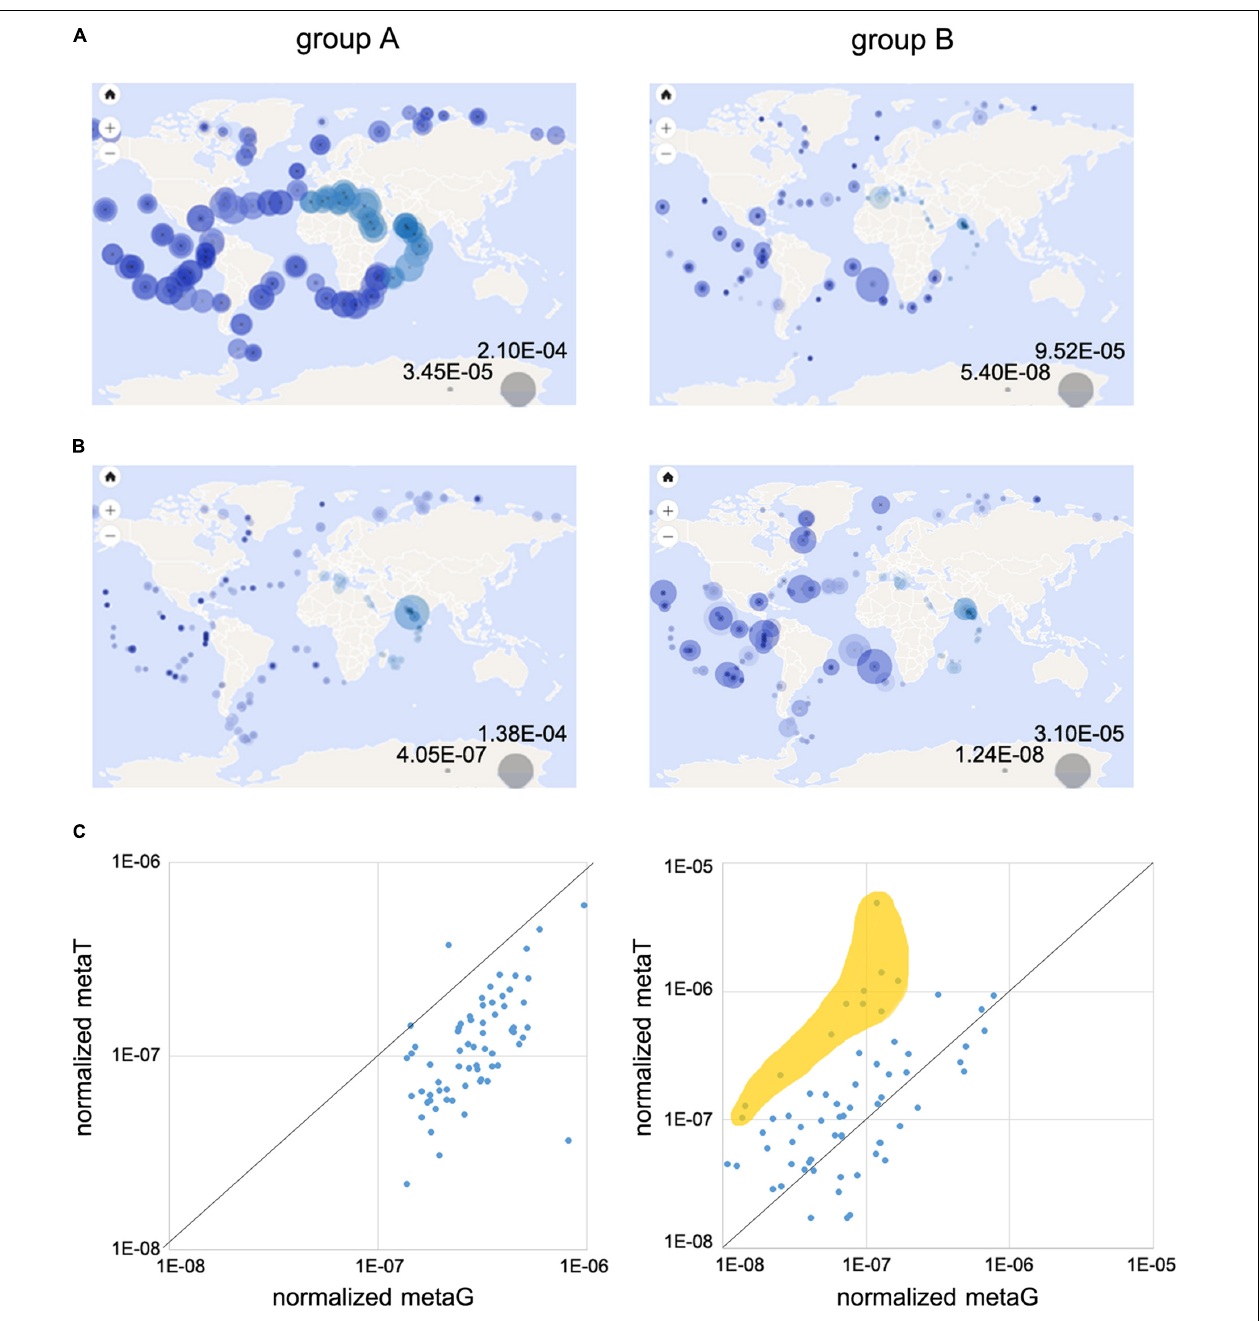
FIGURE 5 | Analysis of oceanic distribution of L-2-HADs into OGA databases. Geographic distribution of relative abundances of group A and group B homologs into metagenomic (A) and metatranscriptomic (B) OGA databases. Global abundance scales are represented by the two gray circles at the bottom right of the maps. (C) Scatterplots of the normalized gene abundance (normalized metaG) vs. normalized transcript abundance (normalized metaT) for each sampling